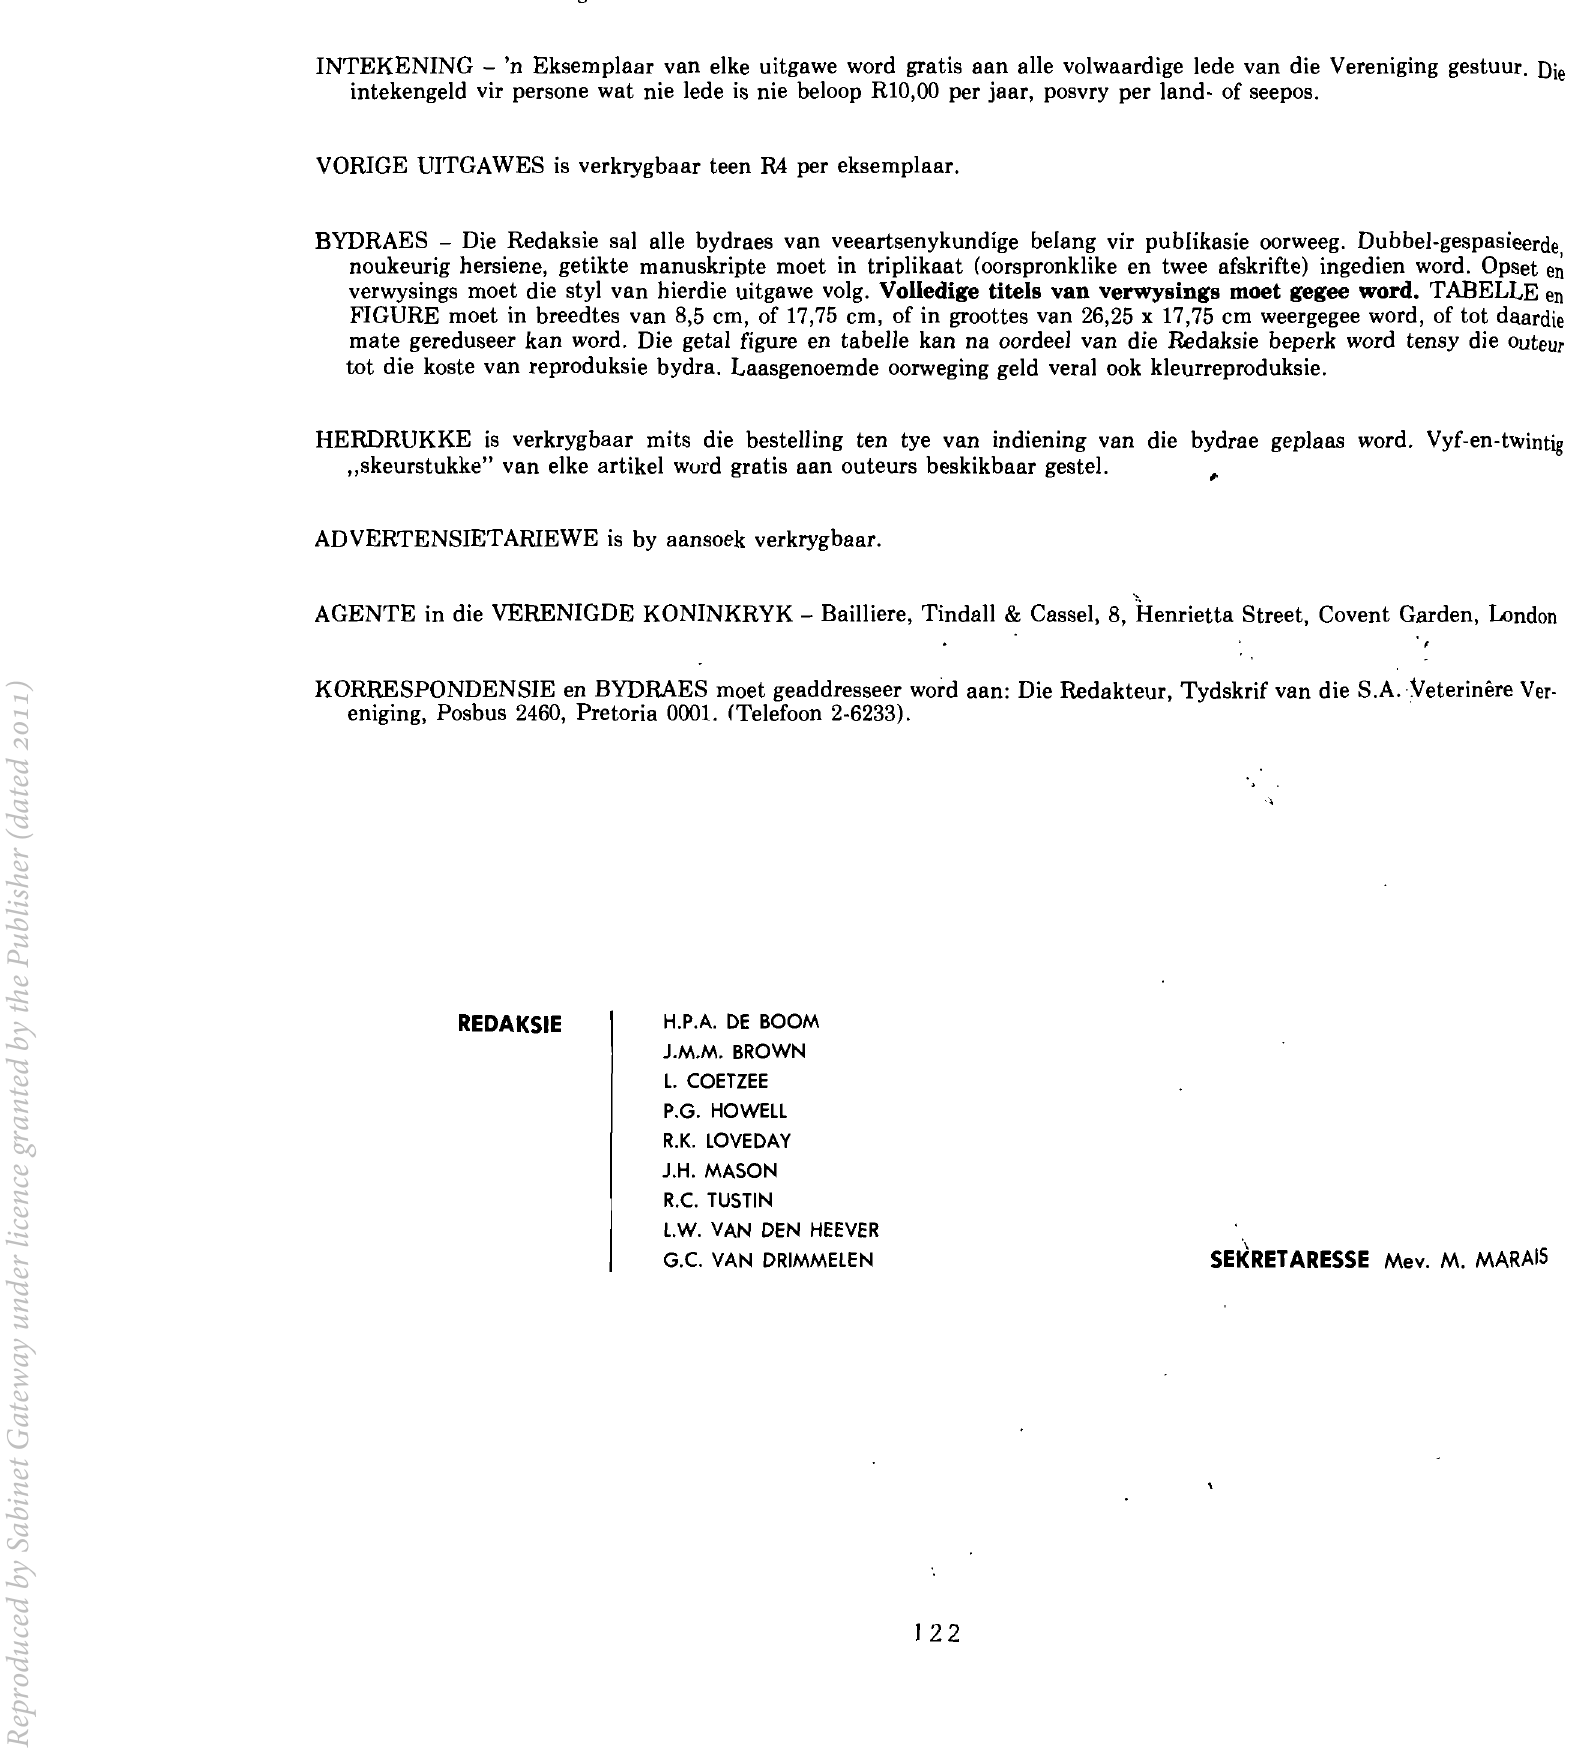
FIGURE moet in breedtes van 8,5 em, of 17,75 em, of in groottes van 26,25 x 17,75 em weergegee word, of tot daardie mate gereduseer kan word. Die getal figure en tabelle kan na oordeel van die Redaksie beperk word tensy die auteur tot die koste van reproduksie bydra. Laasgenoemde oorweging geld vera 1 ook kleurreproduksie. HERDRUKKE is verkrygbaar mits die bestelling ten tye van indiening van die bydrae geplaas word. Vyf-en-twintig "skeurstukke" van elke artikel wurd gratis aan outeurs beskikbaar gestel.